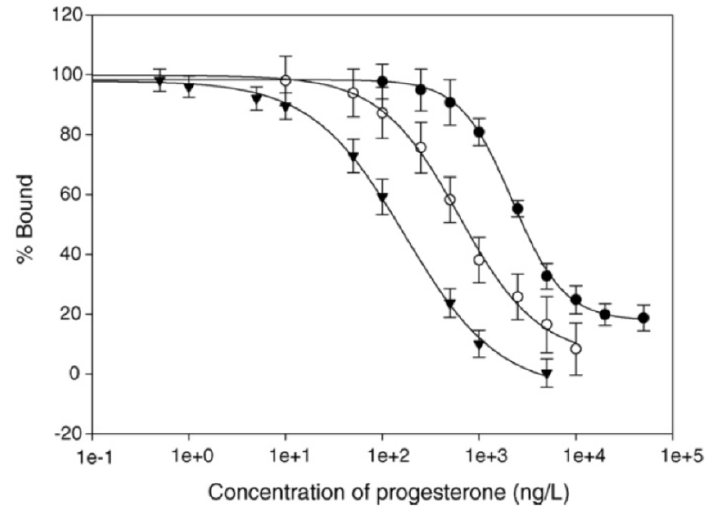
Figure 4. Standard curve plots for progesterone using a mixed SAM layer with protein- conjugate immobilization for SPR immunosensing using mAb only ( ● ), secondary antibody enhancement ( ○ ) and 10 nm immunogold enhancement ( ▼ ). Reprinted from reference [3], with permission from Elsevier. Copyright